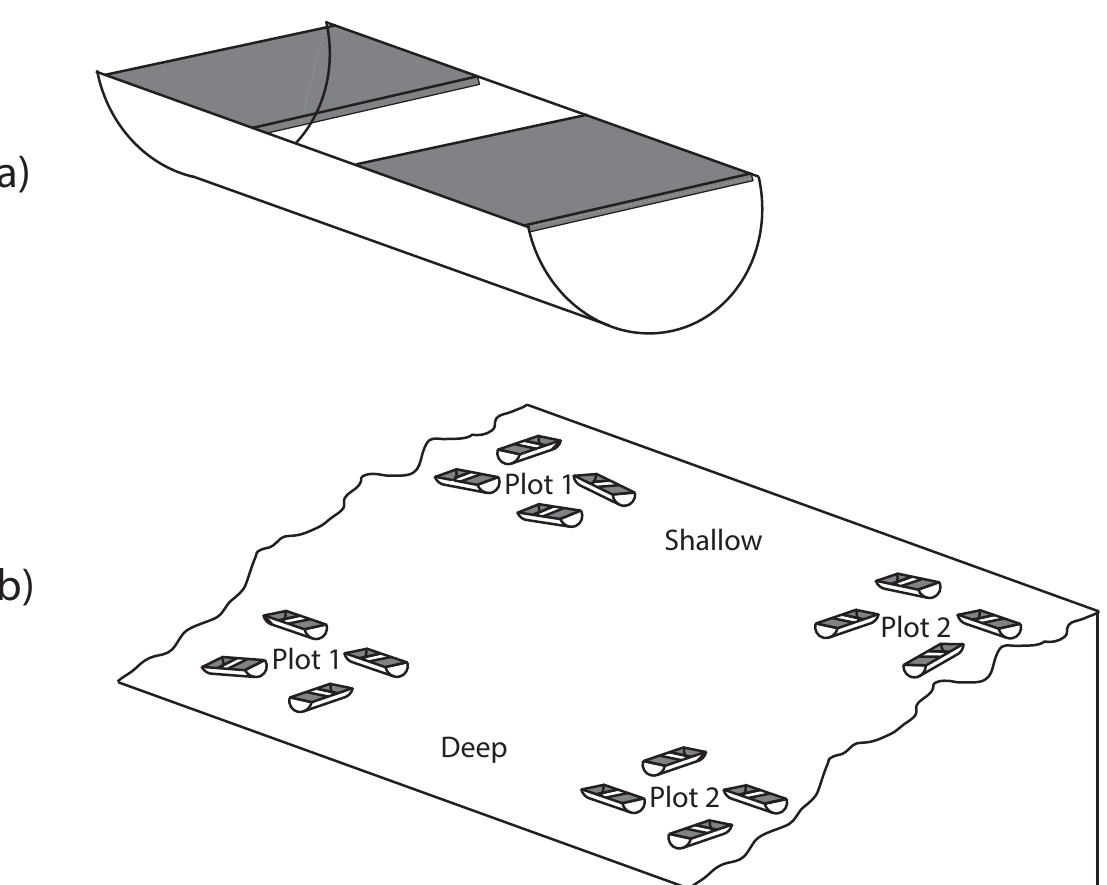
Fig 2. Settlement panels. (a) Two tiles were situated in the top of a trough formed from one-half of a PVC pipe; (b) Experimental design at each site showing groups of eight tiles, two shallow sites and two deep